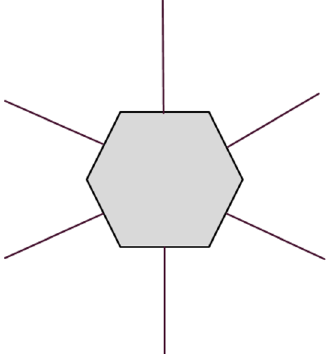
Figure 16. A perfect tensor, which is a stabilizer state maximally entangled across any bipartitions. Each leg represents a physical